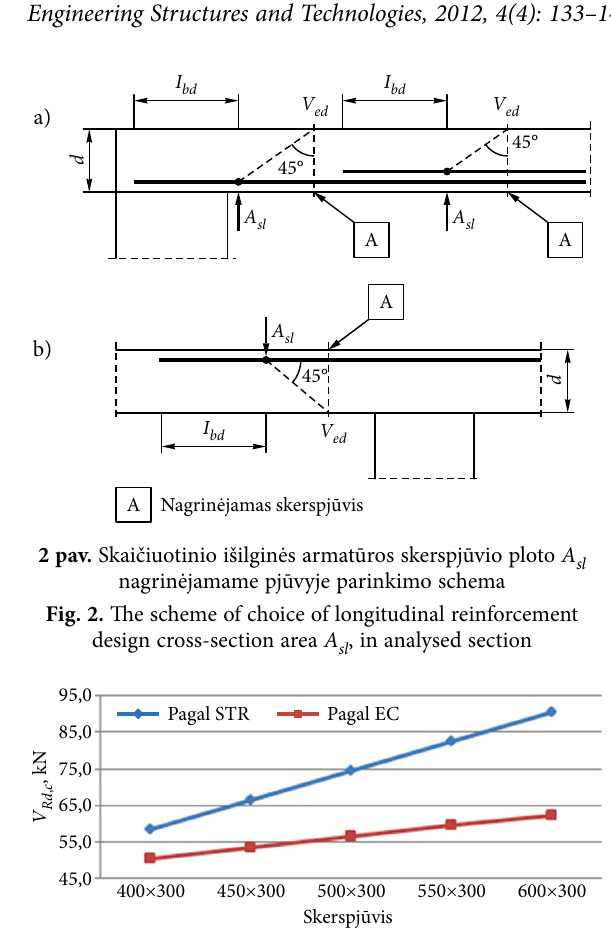
3 pav. Lenkiamųjų elementų be skersinės armatūros įstrižojo pjūvio stiprumo priklausomybė nuo skerspjūvio aukščio Fig. 3. The relationship between shear strength of bending elements without shear reinforcement and cross-section height